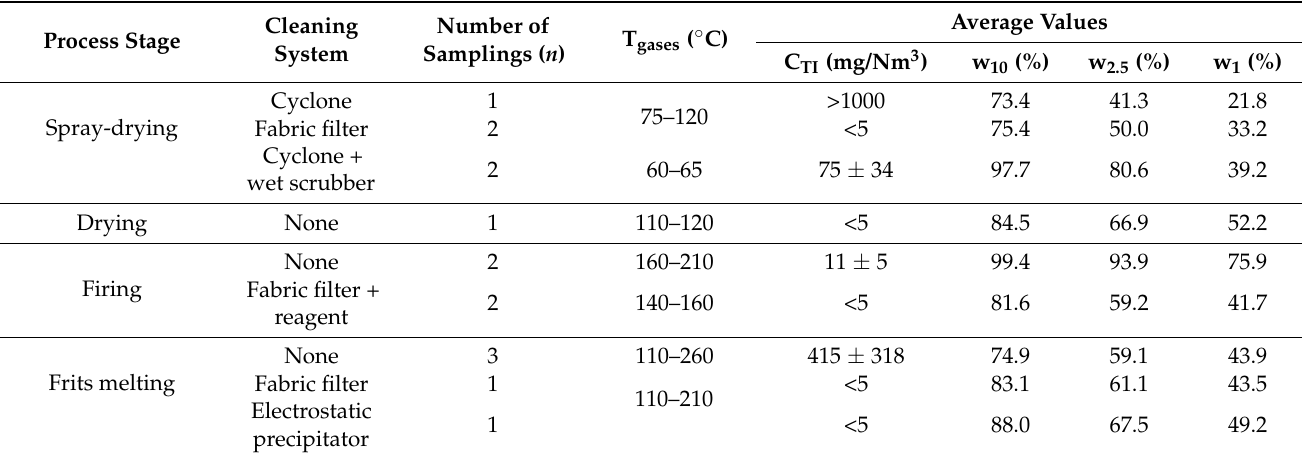
Table 5. w 10 , w 2.5 , and w 1 obtained during drying, spray-drying, firing, and frits melting (medium- and high-temperature